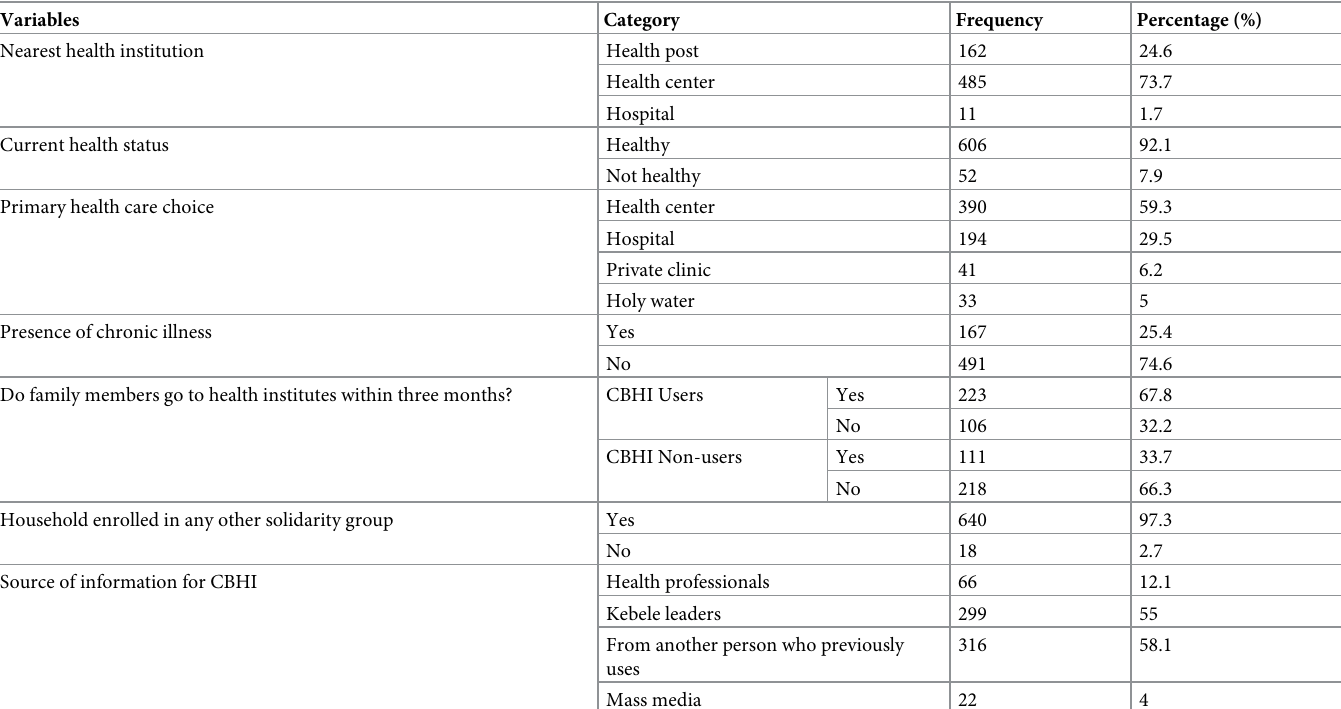
Table 2. Health care access and related causes and community-based health insurance of respondents in South Gondar Zone, Northwest Ethiopia, 2021 (n =